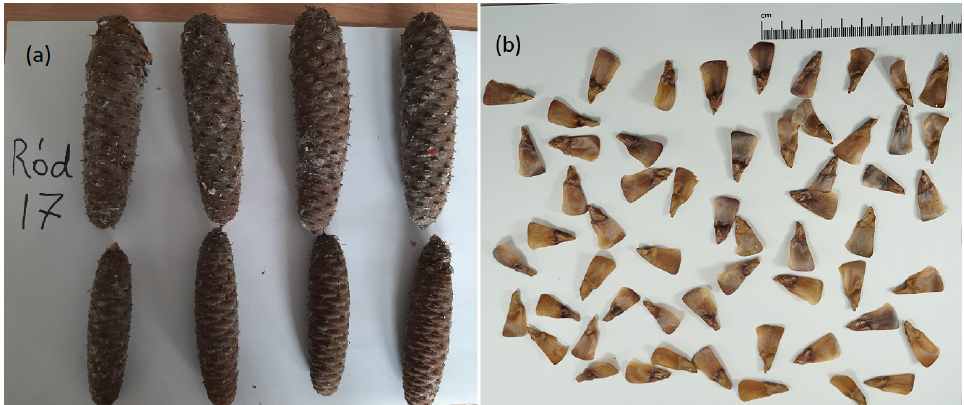
Figure 3. Silver fir cones of a half-sib family N17 ( a ) (photo A. Marozau) and collected seeds ( b ) (photo K. Wiłamowski).